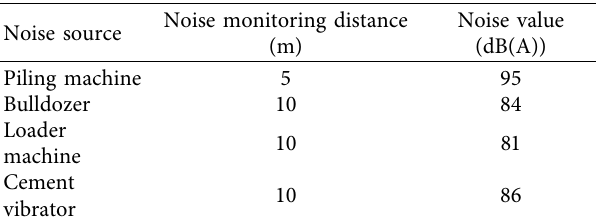
Table 4: Noise values of construction machines. Table 5: Noise influence range of construction